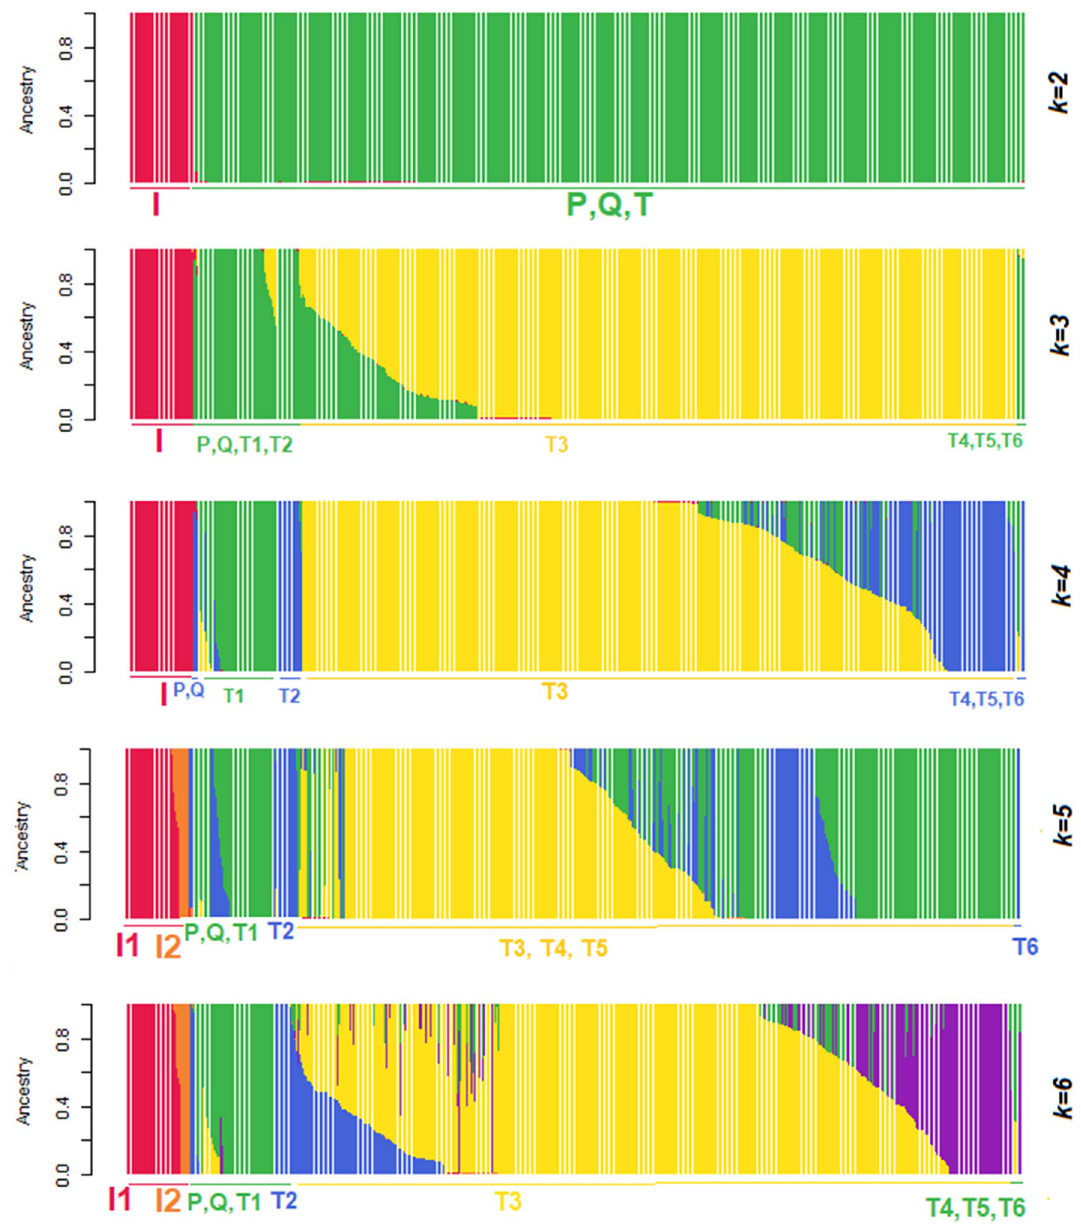
Figure 2. Population structure of cattle mitochondrial sequence variants using Admixture for a pre-defined number of populations ( k ) ranging from 2 to 6. Population structure annotated with individual animal haplogroups (I1, I2, P, Q, T1, T2, T3, T4, T5, T6) determined from